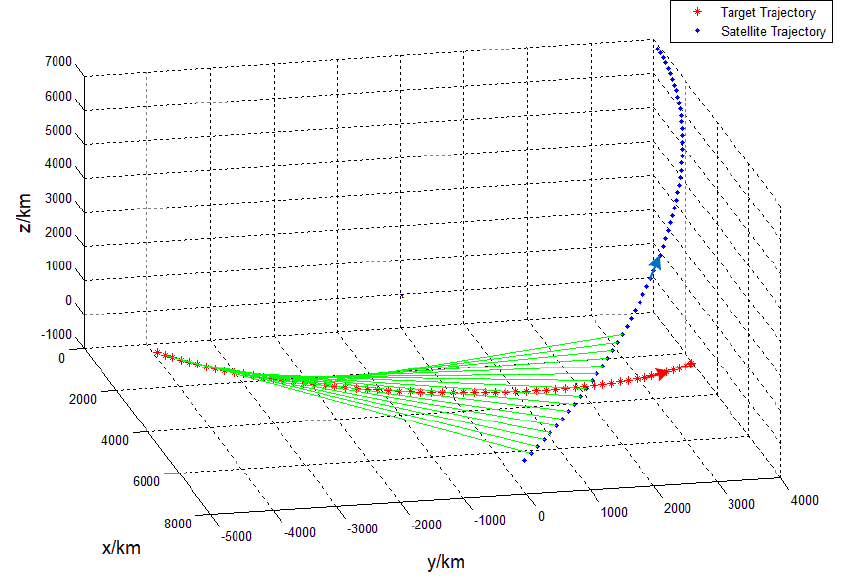
Figure 10. Trajectory of satellite and target with access link.